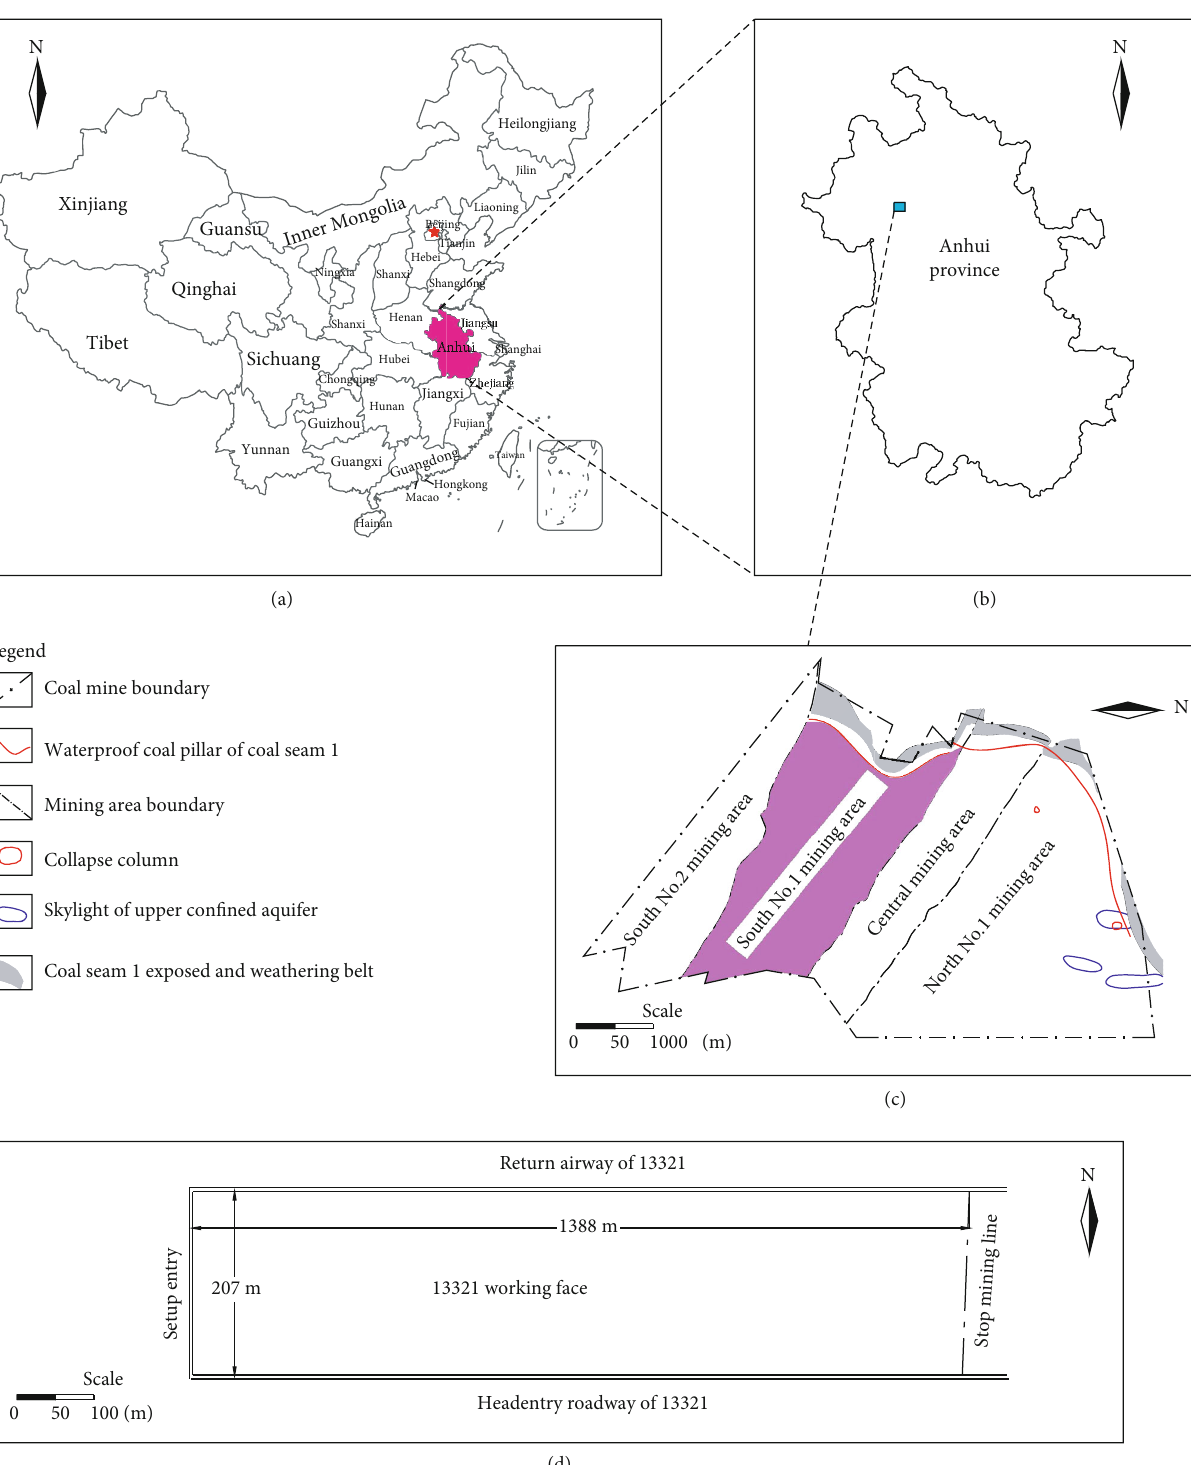
Figure 1: Location of the study area in China including (a), Huainan coal fi eld within Anhui province (b), schematic diagram of stope distribution (c), and 13321 working face located in South No.1 mining area